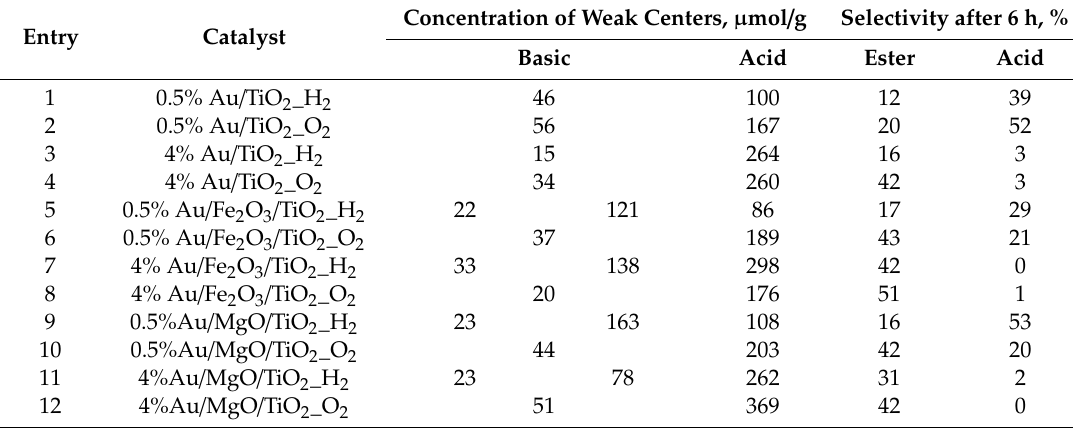
Table 6. Acid-basic properties of catalysts and corresponding selectivity data in n -octanol oxidation. Concentration of Weak Centers, µ mol / g Selectivity after 6 h, % Entry Catalyst Basic